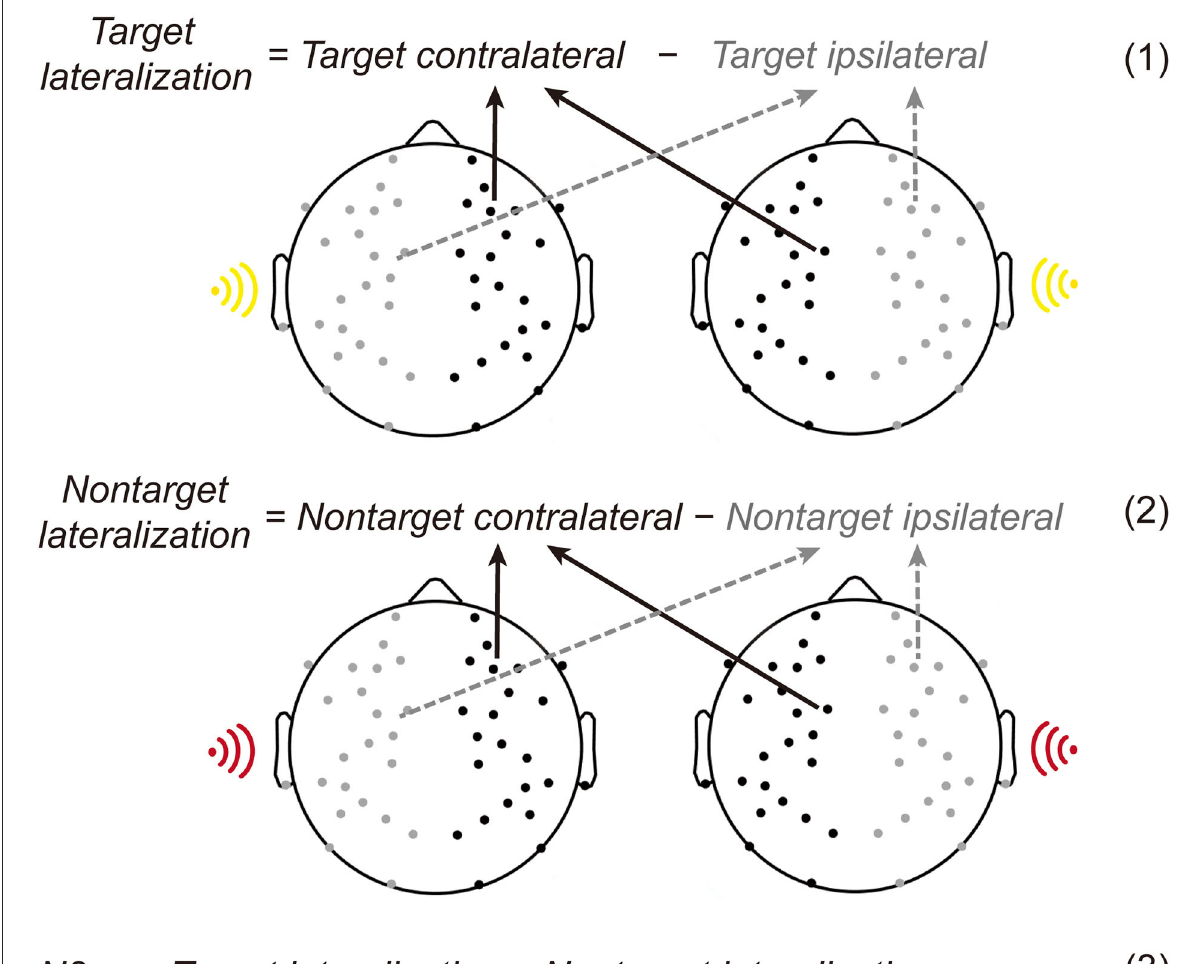
FIGURE3 Illustration of lateralized ERP components. The target/non-target deviants of ipsilateral voltage were the average of the right deviants elicited voltage in the right hemisphere and the left deviants elicited voltage in the left hemisphere. And the target/non-target deviants of contralateral voltage were the average of the right deviants elicited voltage in the left hemisphere and the left deviants elicited voltage in the right hemisphere. Then, the lateralization effect was the difference in subtracting the ipsilateral voltage from the contralateral voltage [see the Formulas (1) and (2)]. The N2ac component reflecting auditory spatial selective attention was calculated by subtracting the lateralization in non-target deviants from the target deviants [see the Formula